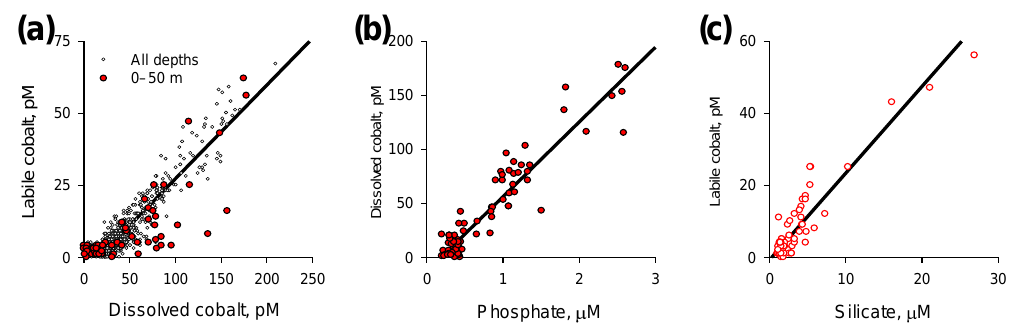
Figure 7. (a) The relationship between dissolved cobalt (dCo) and labile cobalt (LCo) in the South Pacific. LCo increases linearly with dCo with a slope of 0.33 (white dots, R 2 = 0.88), except for the upper 50m (red dots), where samples fall below this trend due to preferential depletion of LCo by phytoplankton. (b) In the 0–50m range, dCo strongly correlates with phosphate ( R 2 = 0.89). (c) LCo is preferentially removed from surface waters (0–50m) and tracks silicate ( R 2 = 0.90).